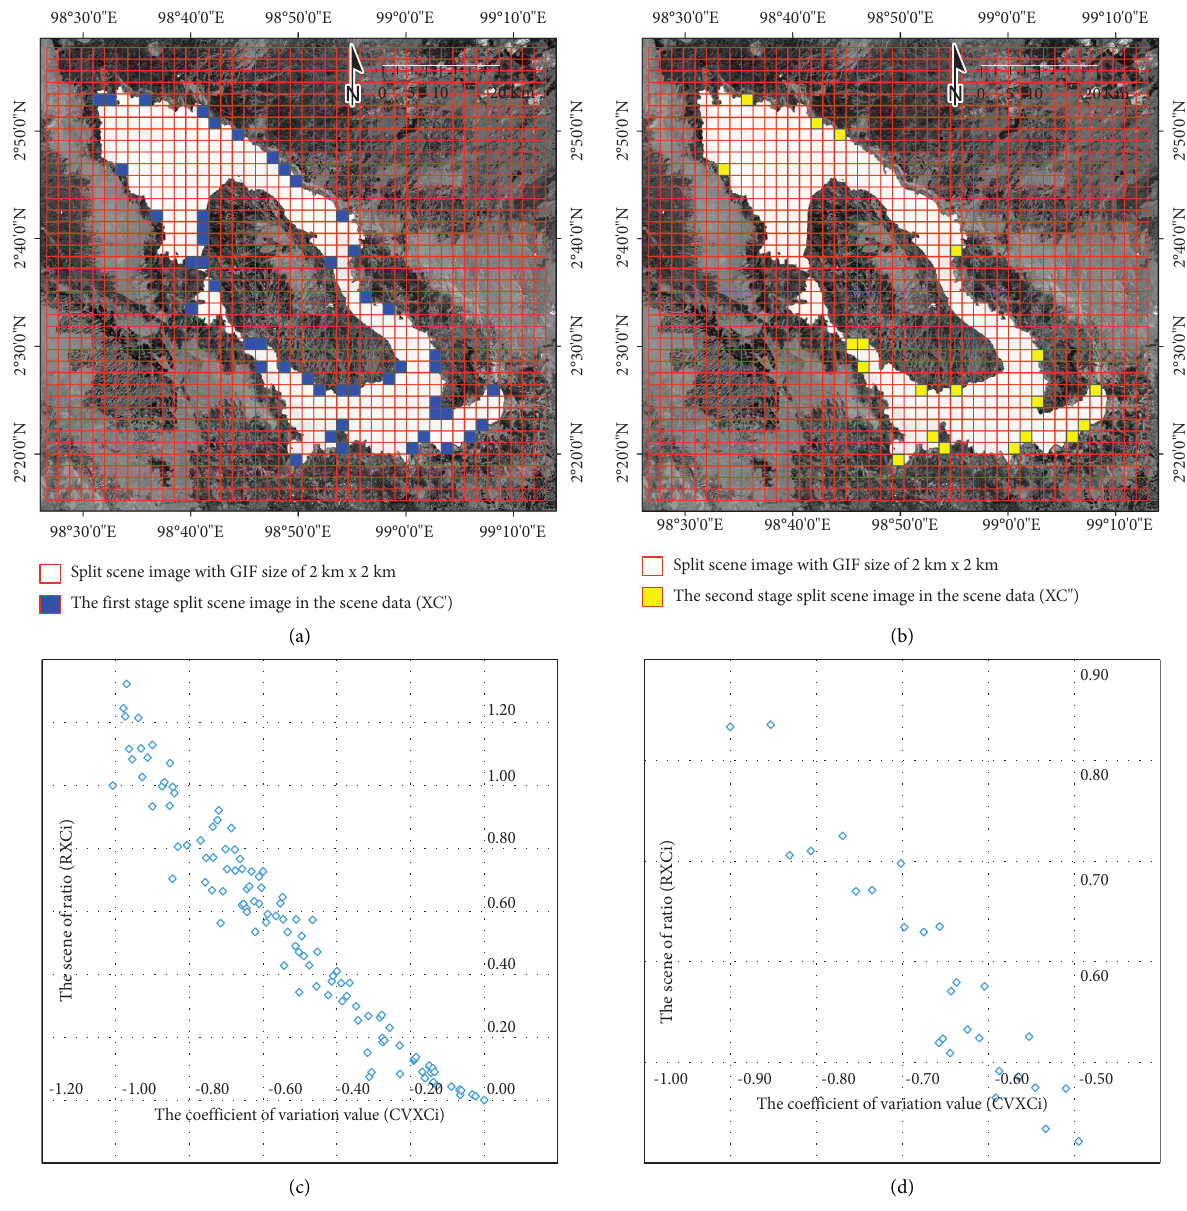
Figure 5: (a) Location of the split scene image with GIF was at a size of 2km × 2km for the first-stage split scene image in the scene image data ( XCi ′ ) . (b) Location of the split scene image with GIF for the second-stage split scene image in the scene image data ( XCi ″ ) . (c) The coefficient of variation value on the first-stage split scene image can be plotted on the X -axis, and the scene ratio value can be plotted on the Y -axis. (d) Plot of the second-stage split scene image for the coefficient of variation value on the X -axis and the ratio of the scene value on the Y